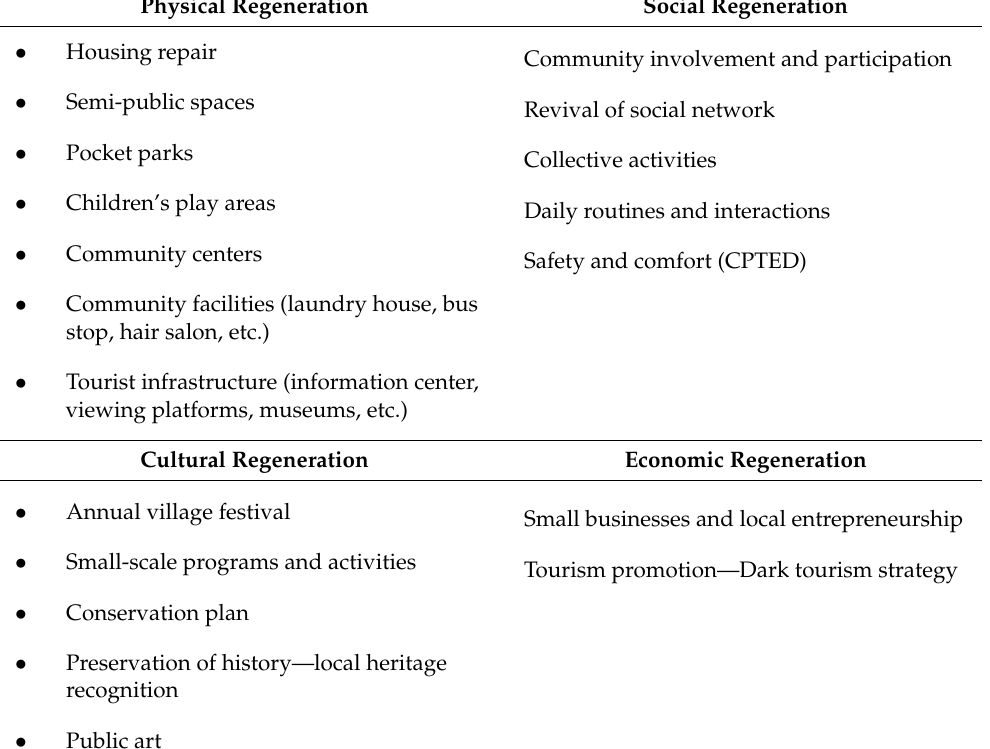
Table 1. Integrating Sense of Place Elements within Regeneration